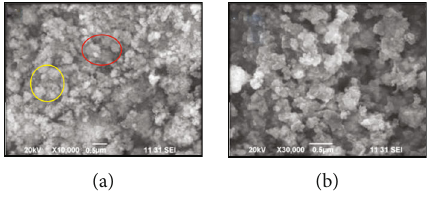
Figure 3: SEM images of (a) CuO and (b) CuO/PVA